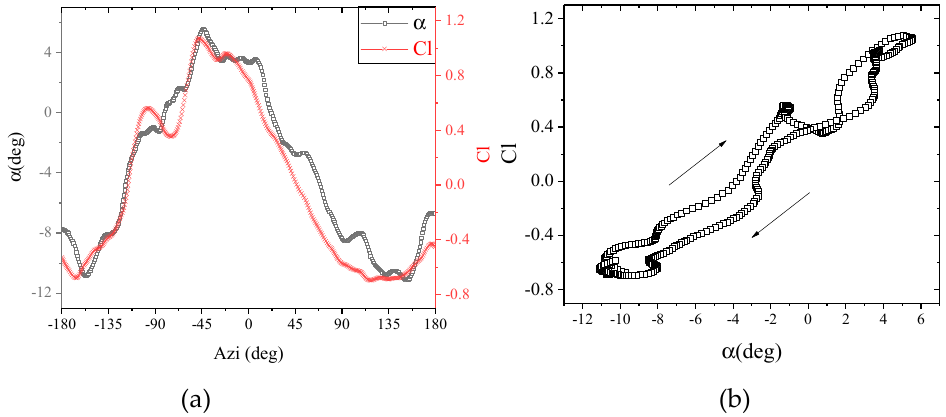
Figure 22. ( a ) The variation of angle of attack and lift coefficient in one rotation period, and ( b ) dynamic response of lift coefficient varying with the angle of attack.